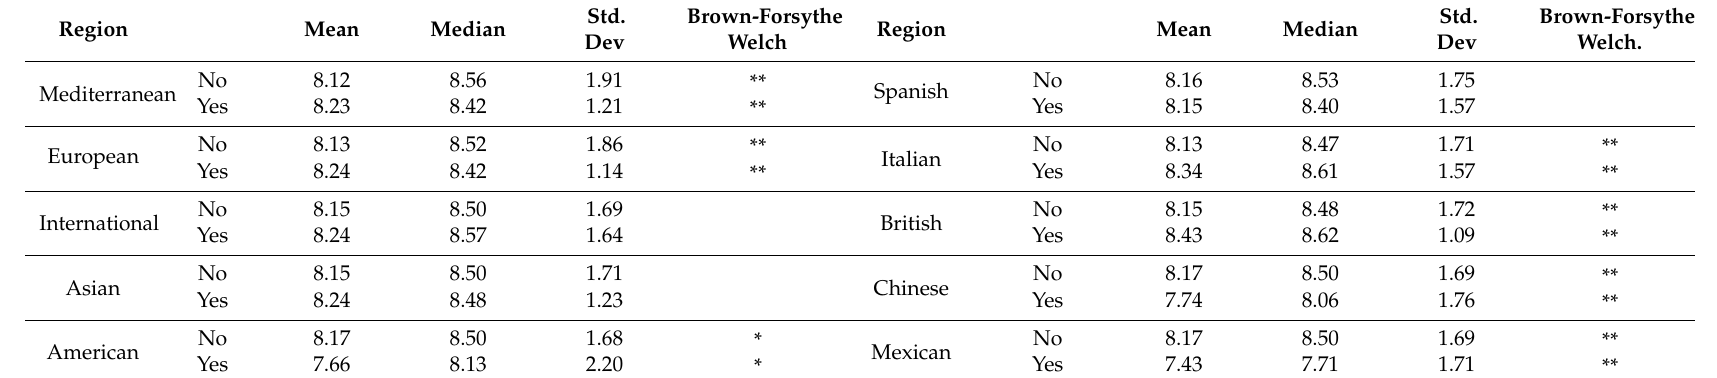
Table A2. Comparison of scores (1–10) means per region and per country (Brown-Forsythe and Welch tests). N = 7558.